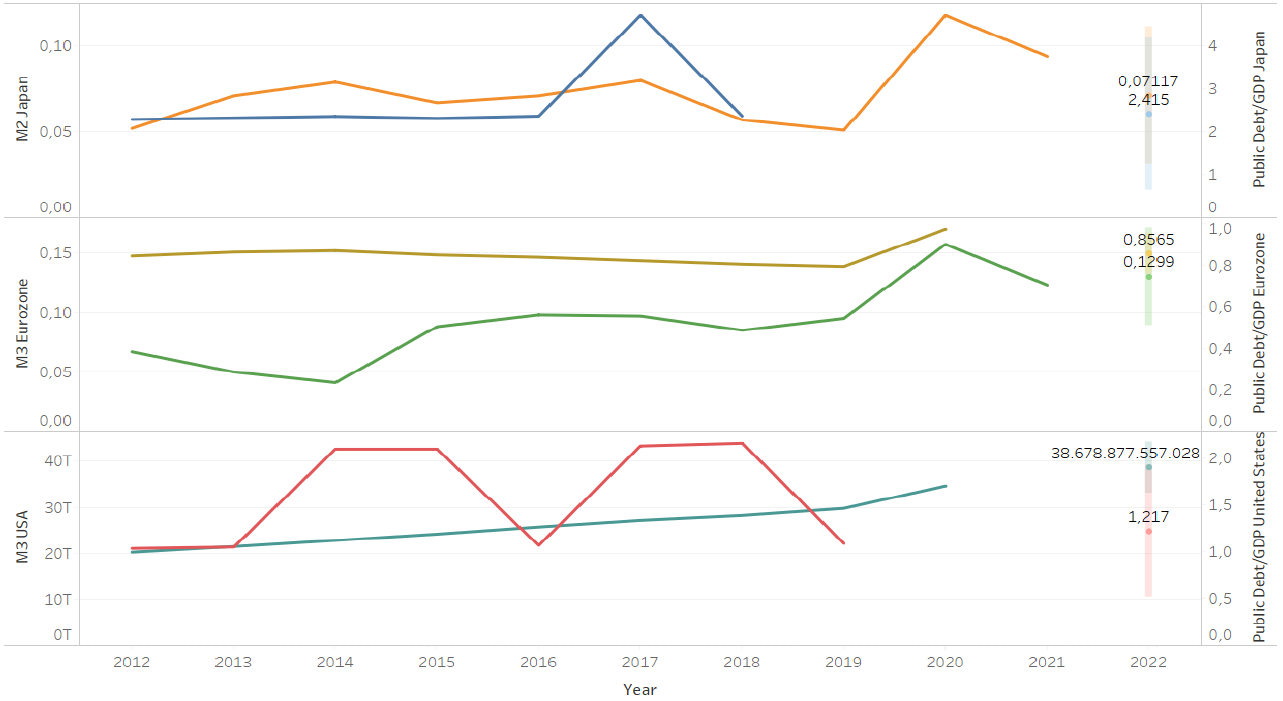
Figure 1. M2–M3 ratio with public debt/GDP prediction. Source: own elaboration via Tableau Desktop professional edition and data from the International Monetary Fund, ECB, Fed, and BOJ.